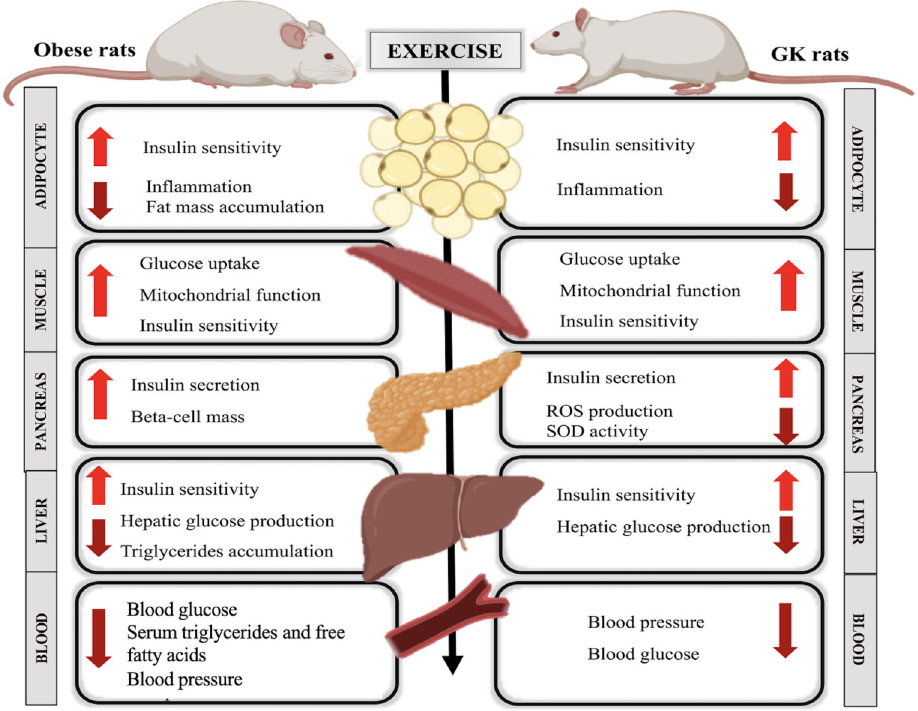
Figure 5. The effects of physical exercise on different tissues and organs of obese and non-obese (GK: Goto-Kakizaki) type 2 diabetes mellitus